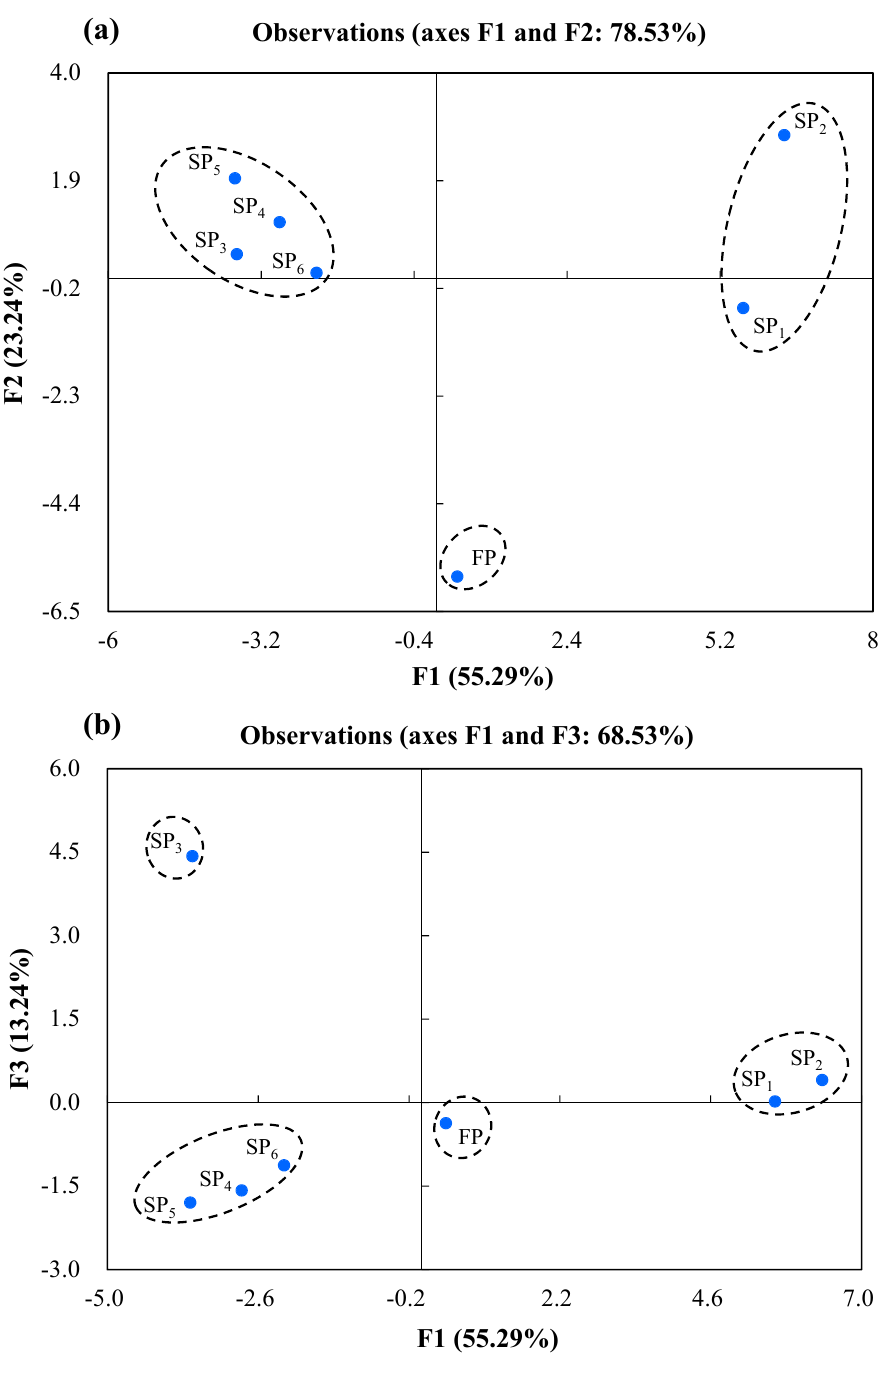
Figure 2. Score plots of PCA of the fresh and stewed pork. ( a ) PC1 plotted against PC2 and ( b ) PC1 against PC3. FP, fresh pork; SP 1 , stewed pork with water; SP 2 : stewed pork with water and salt; SP 3 : stewed pork with water, salt and spices; SP 4 : stewed pork with water, salt, spices and soy sauce; SP 5 : stewed pork with water, salt, spices, soy sauce and sugar; SP 6 : stewed pork with water, salt, spices, soy sauce, sugar and cooking wine.